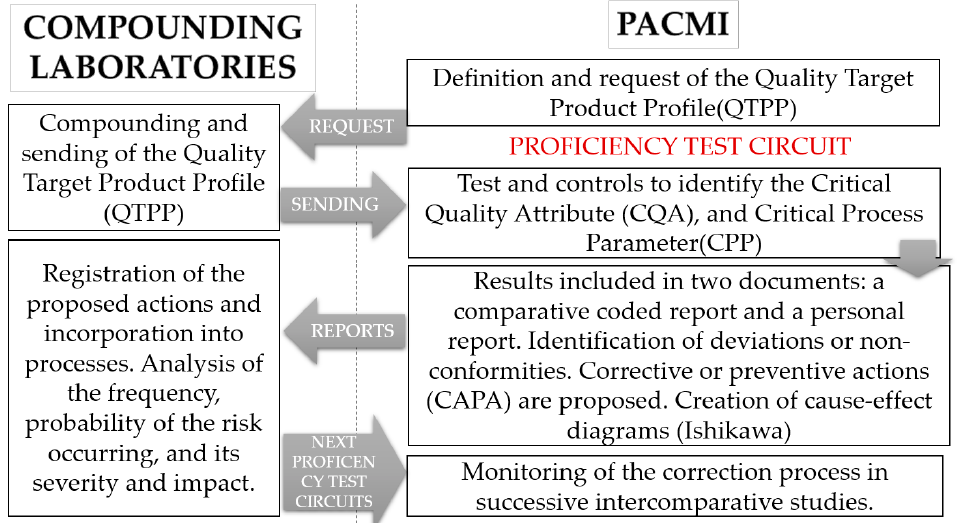
Figure 1. Work methodology in the PACMI proficiency test programs .